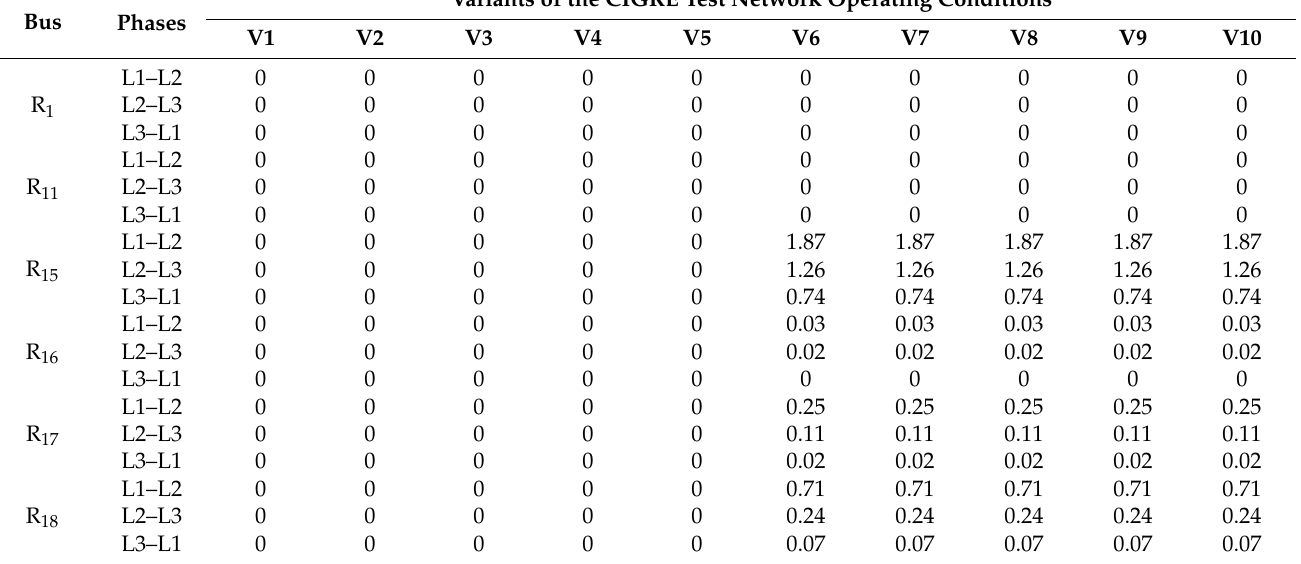
Table 6. The risk of dropping below the lower limit of the bus voltage R S CIGRE test